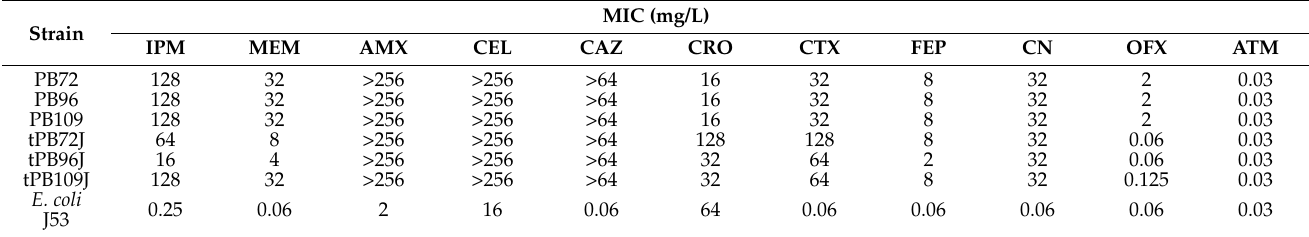
Figure 4. Phylogenetic tree of 298 bla NDM-1 -positive P. mirabilis by core genome single nucleotide polymorphisms (SNPs). Twenty isolates shaded by violet were from this study, and 278 genomic data were download from the National Center for Biotechnology Information (NCBI). Different clusters were tagged and shaded different colors. The genome labeled with left triangle were collected from animals (54 in total), while others were from humans. Based on phylogenetic results of whole genome sequencing (WGS), 298 bla NDM-1 P. mirabilis were clustered in 6 major clades: A, B, C, D, E and F, labeled by different color backgrounds. In our study, the 20 bla NDM-1 P. mirabilis isolates colored by purple background were clustered into 4 main clades: B, C, D and F, in which clade B was predominant. Table 2. Antibiotic susceptibility profiles of the 3 bla NDM-1 -bearing P. mirabilis strains and the corresponding transconjugants to different antibiotics